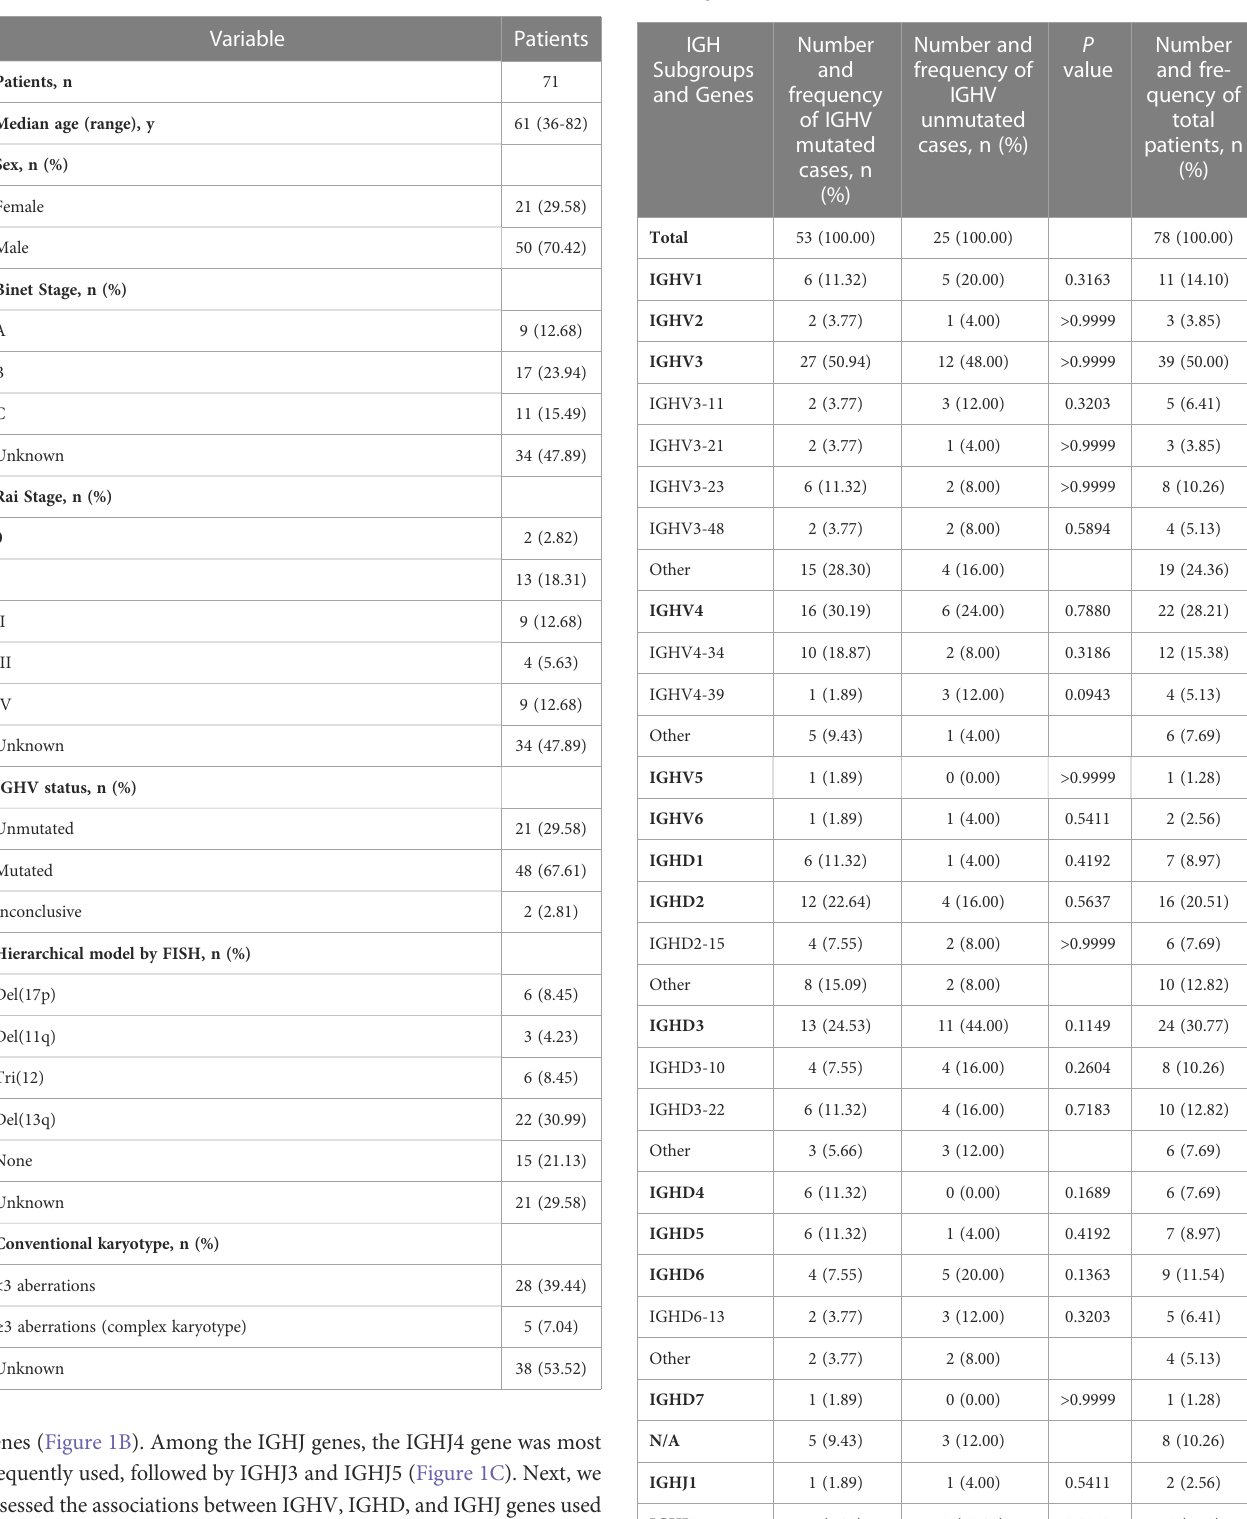
TABLE 1 Summary of the clinical and molecular characteristics at baseline.